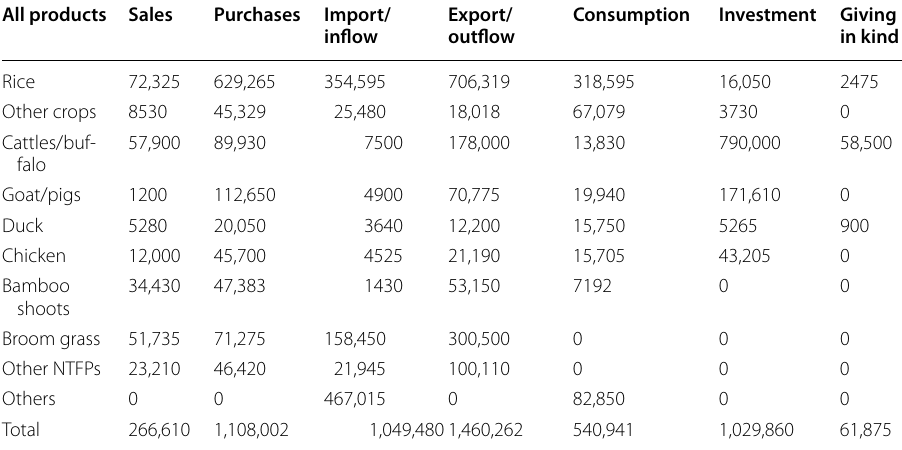
Table 7 Product transactions in the village input–output table (unit: 1000 Kip). Source: Field survey data, March 8, 2016